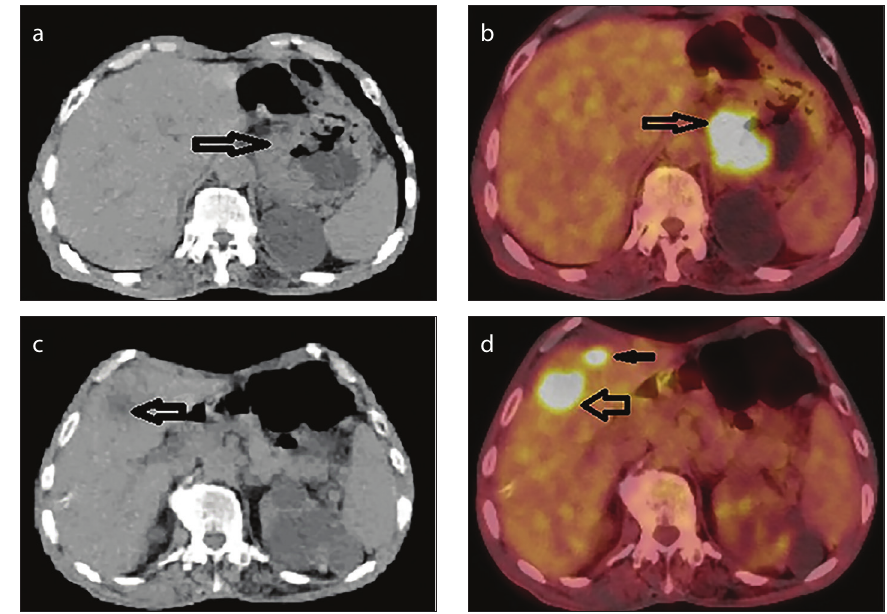
Figure 1. a, b. (a) Wall thickening and an appearance of the mass are observed in the primary tumor area (arrow head) of the case with a signet-ring cell gastric adenocarcinoma in axial section CT image. (b) In the PET/CT fusion image of the same patient, metabolic F-18-FDG involvement in the primary tumor and other areas in the image is within normal limits.